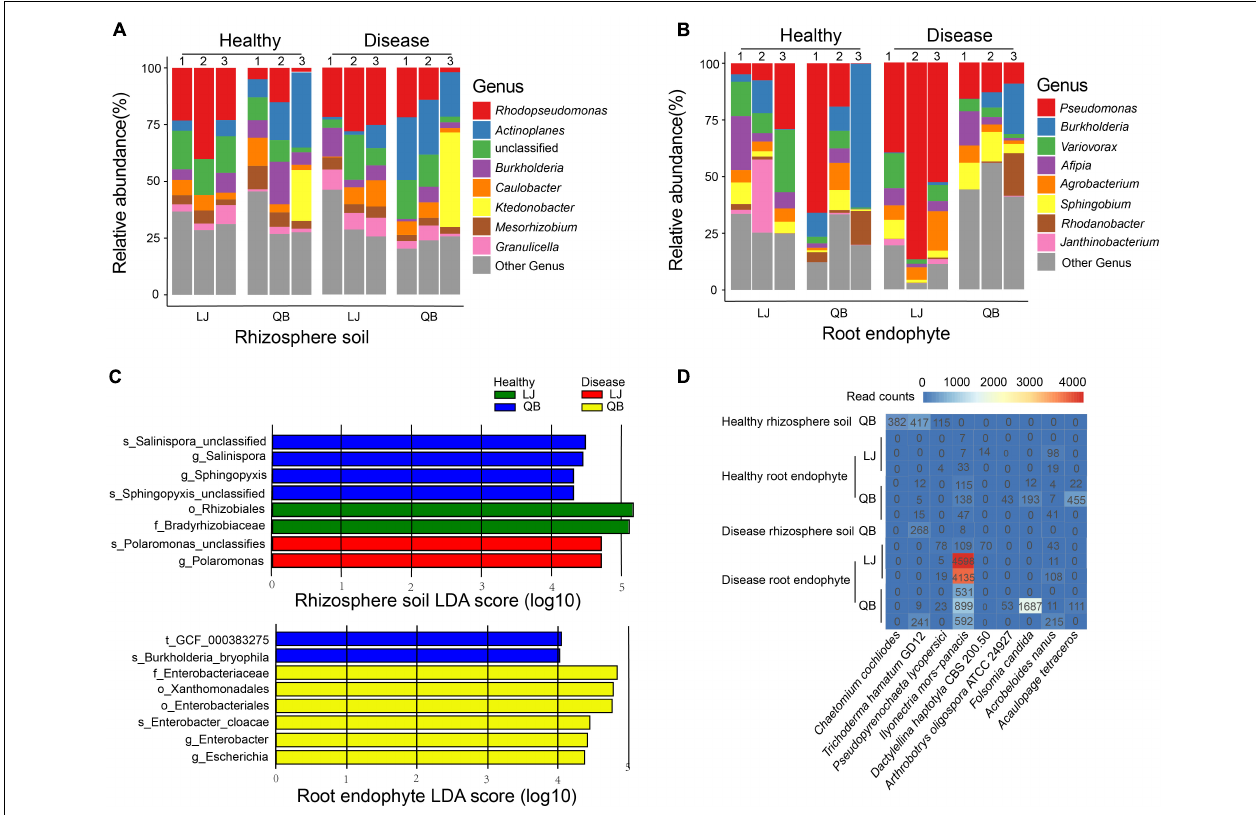
FIGURE 3 | Genus composition heatmaps and corresponding histograms for the microbial communities associated with healthy and root rot Panax notoginseng . (A,B) Relative abundance of the top eight species in each sample. (C) Species differences in the rhizosphere soil and root endophyte microbial communities associated with healthy and root rot P. notoginseng . Display the species with significant differences (LDA > 4) between the groups. Panel (D) shows the top nine species of eukaryotes present in the samples. Lijiang (LJ) and Qiubei (QB) and 1, 2, and 3 represent biological replicate in each location.